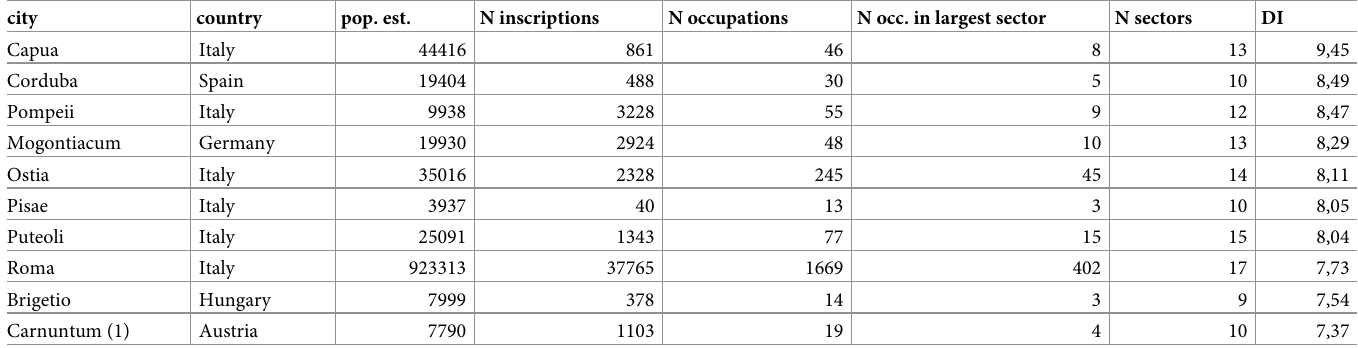
Table 2. 10 cities with the highest DI